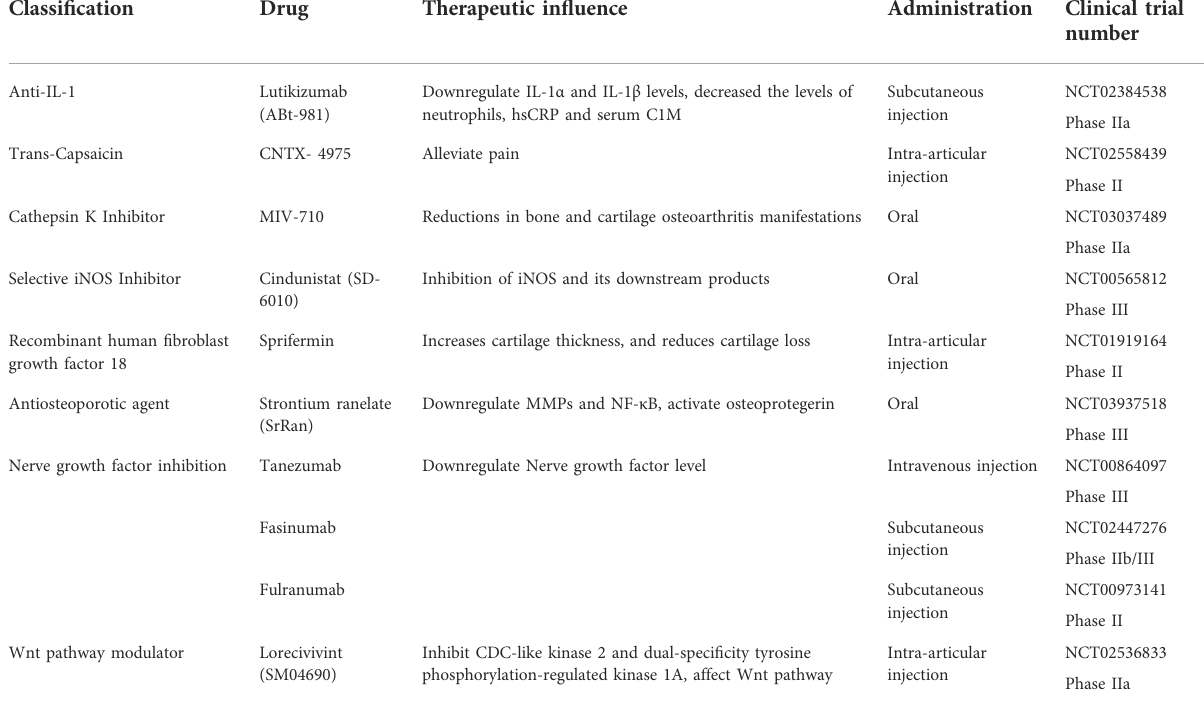
TABLE 2 Clinical trials of some chemical drugs for